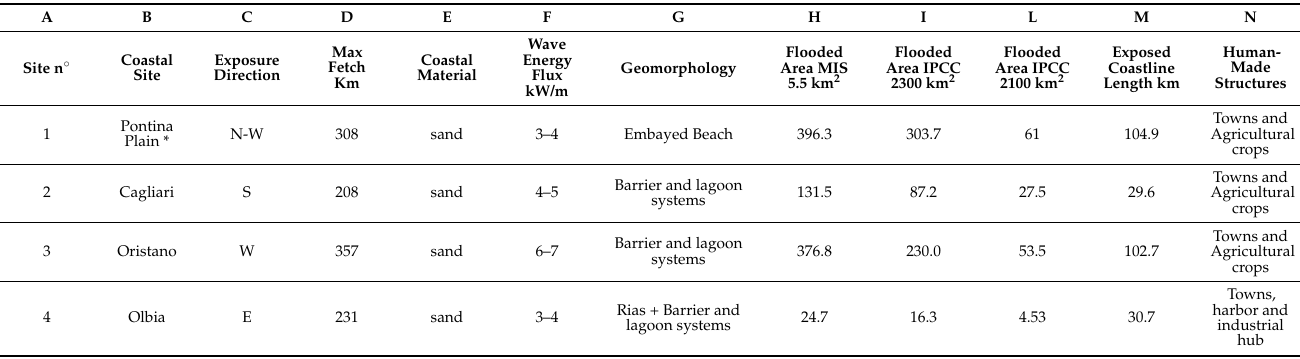
Table 4. A: coastal sites; B: exposure; C: maximum fetch; D: max fetch; E: coastal material; F: wave energy flux kW \ m. This is an average between two types of data in [56]. Maximum waves and energy are found between the Balearic Islands and Capo Caccia with values between 9 and 10.0.; G: geomorphology; H: flooded area during MIS 5.5 km 2 ; I: projection flooded on the map (Figure 13),* we divided it into three different areas (Pontina 190, Fondi 64.5 and Laghi Costieri 49.2; M: exposed coastline Length km; N: human-made structures.